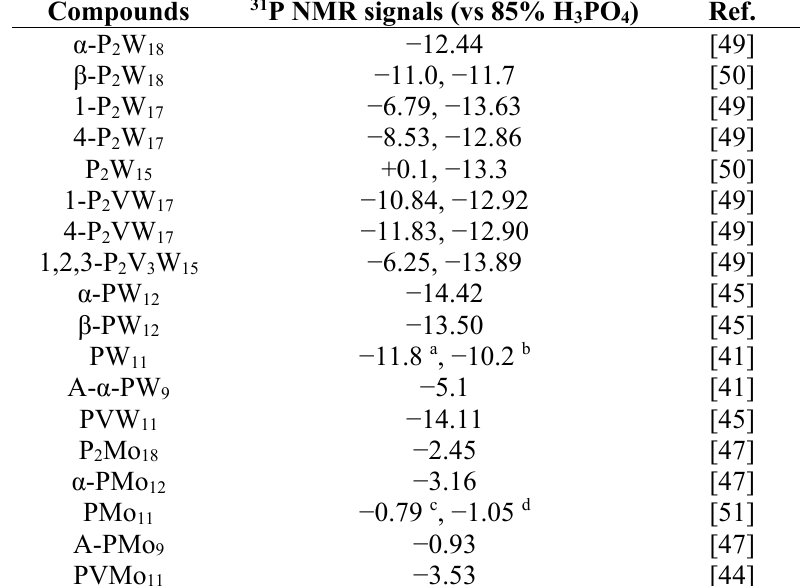
Table 2. 31 P NMR signal of phosphorus-centered polyoxometalates